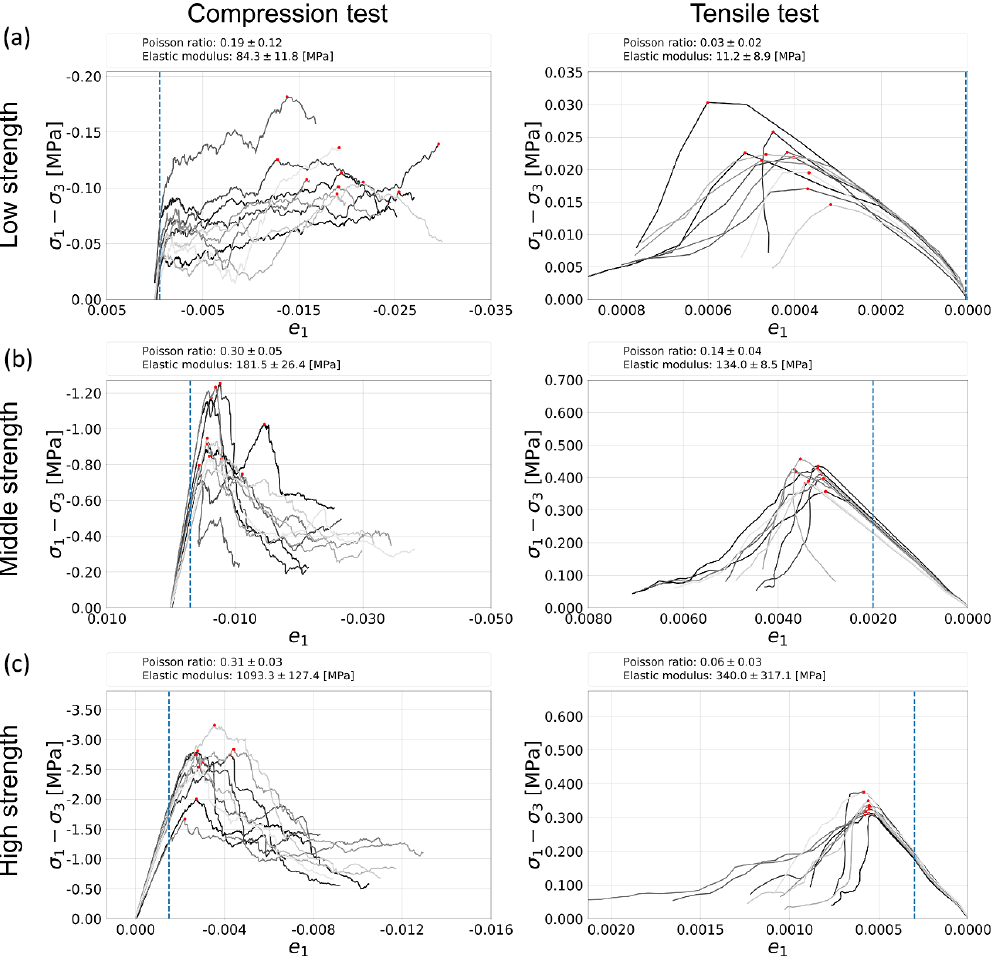
Figure B5. Differential stress vs. vertical strain for CC and DT tests for a confining pressure of 0.1MPa: (a) lacustrine mud; (b) alluvium sediments; (c) holocene salt rock. The dashed line indicates elastic limit which was used to determine elastic parameters displayed above the graphs. Red dots mark the peak